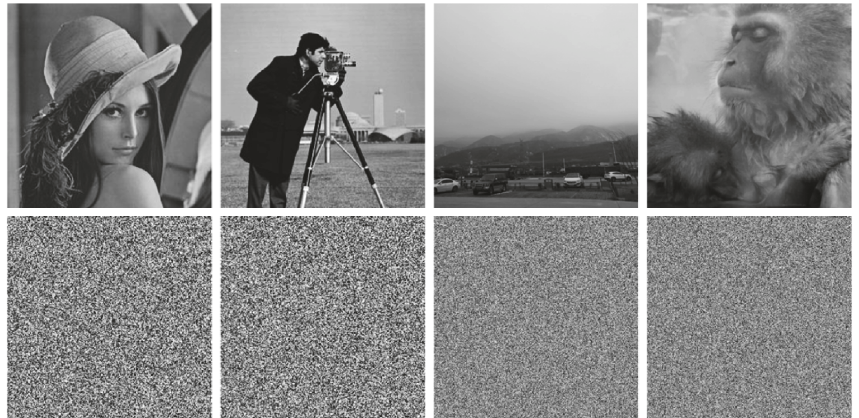
= 0.1 , 𝑥 1 = 0.2 , 𝑥 1 = 0.3 , 𝑥 1 = 0.5 , 2 3 4 5